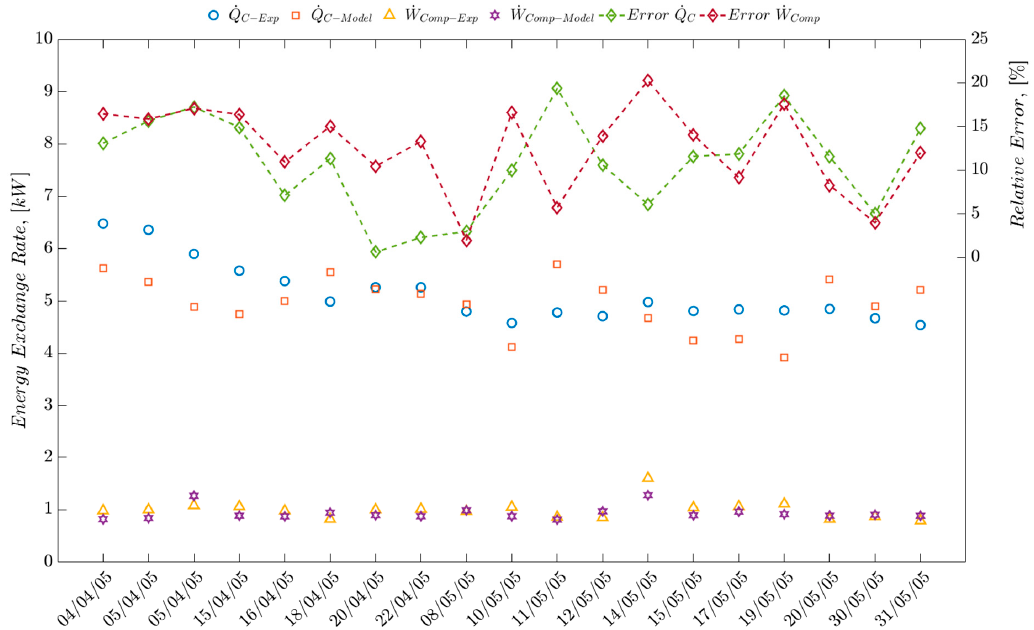
Figure 6. Comparison with experimental data published by Li et al. [52].